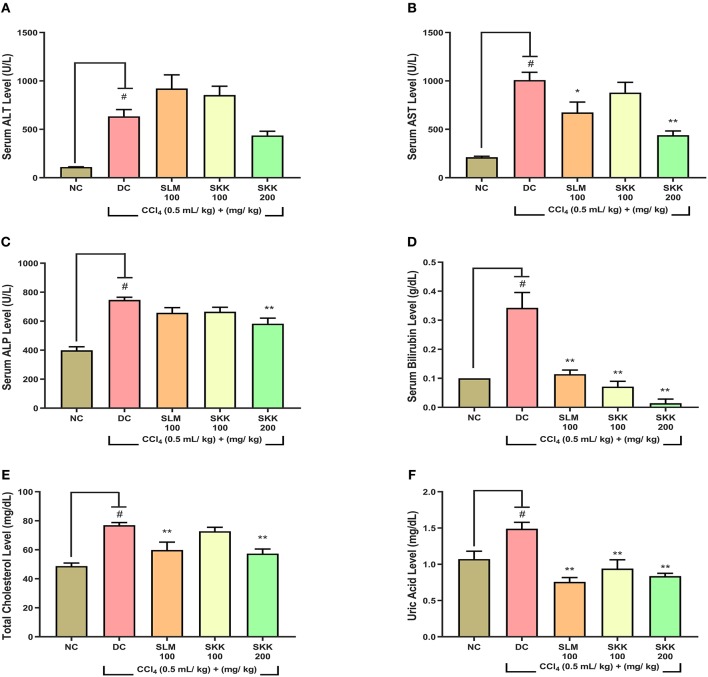
In-vivo biochemical analysis of CCl4 stimulated wistar rats treated with Divya Sarva-Kalp-Kwath (SKK): Wistar rats stimulated with CCl4 showed a significant upsurge in their serum enzyme levels–(A) alanine transaminase (ALT), (B) aspartate aminotransferase (AST), (C) alkaline phosphatase (ALP), (D) total bilirubin, (E) total cholesterol, and (F) uric acid. Co-treatment of the CCl4 stimulated rats with SKK (100 and 200 mg/kg) showed a significant reduction in their serum liver injury biomarkers. SLM (100 mg/kg) was used as a positive control in the study. Results are expressed as Mean ± Standard Error Mean. One-way analysis of variance (ANOVA) followed by Dunnett's multiple comparison t-test was used to calculate the statistical difference. p-value #<0.01; *<0.05; **<0.01.